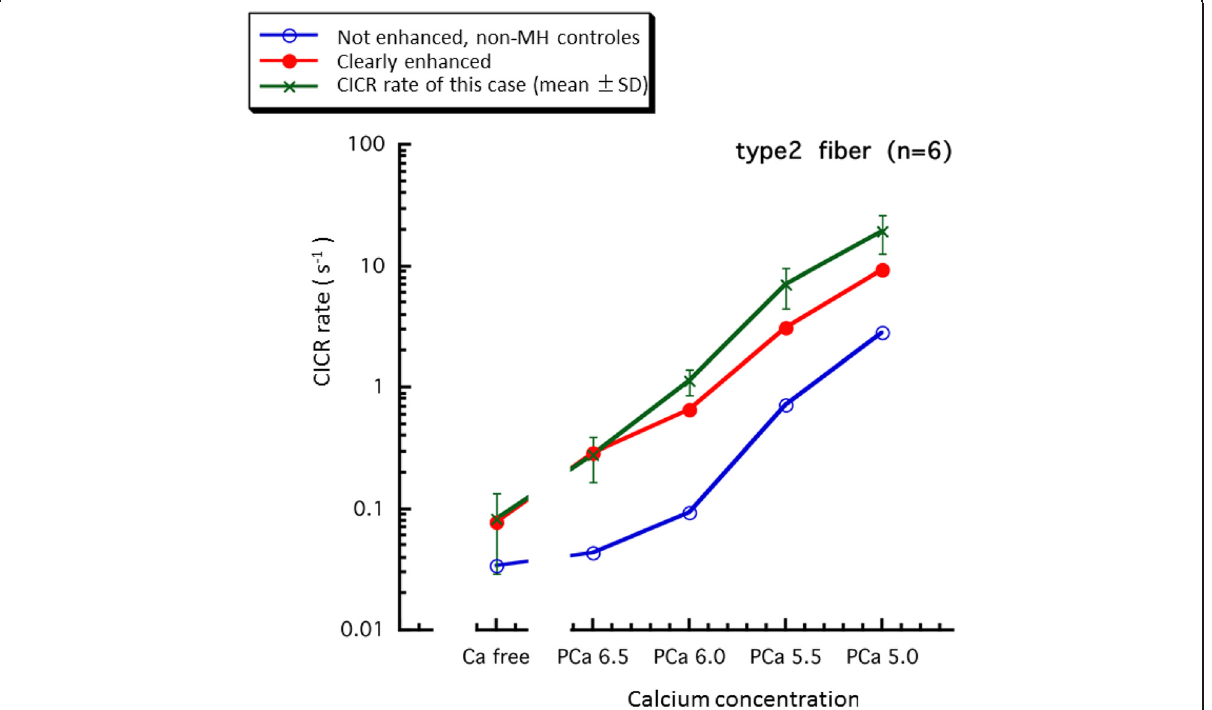
Fig. 2 Comparison between CICR rate of this case and the reference values for malignant hyperthermia susceptibility diagnosis in Japan [14]. The data of this case are compatible with clearly high rate of CICR. Courtesy of Drs. Hirosato Kikuchi and Yasuko Ichihara (Saitama Medical University) for measuring CICR rate of this